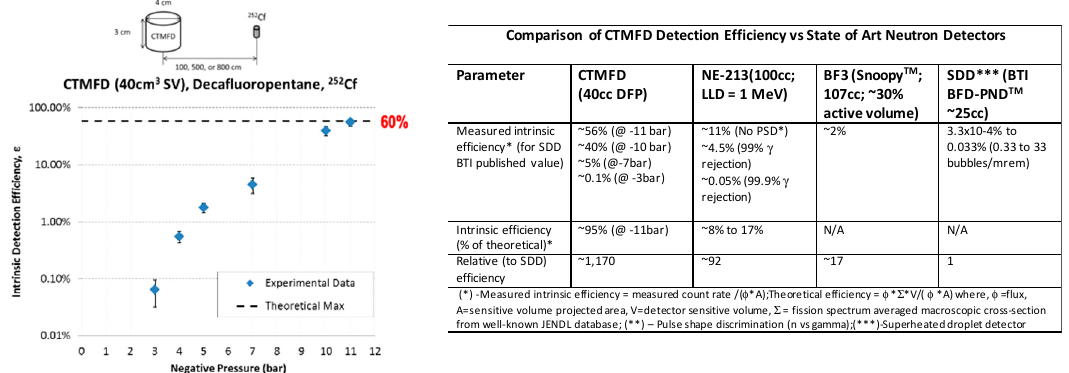
Figure 6. Variation of intrinsic neutron detection efficiency versus P neg and comparison with state-of-art neutron detectors.